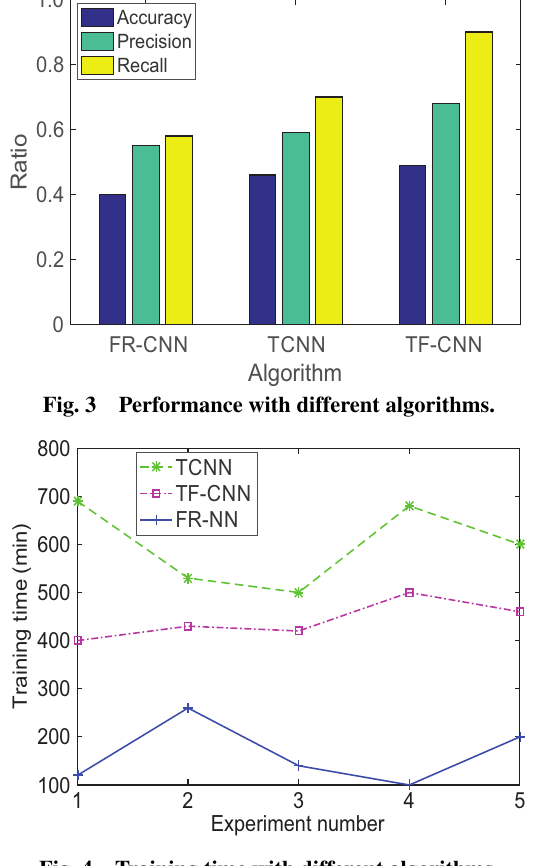
Fig. 6 QoE values for different